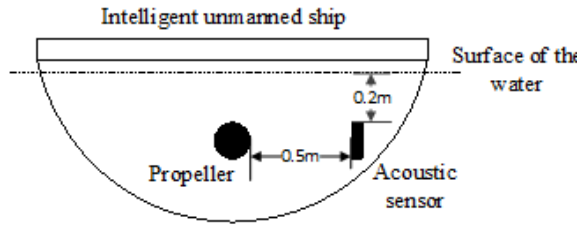
Figure 8. Installation diagram of acoustic sensor.